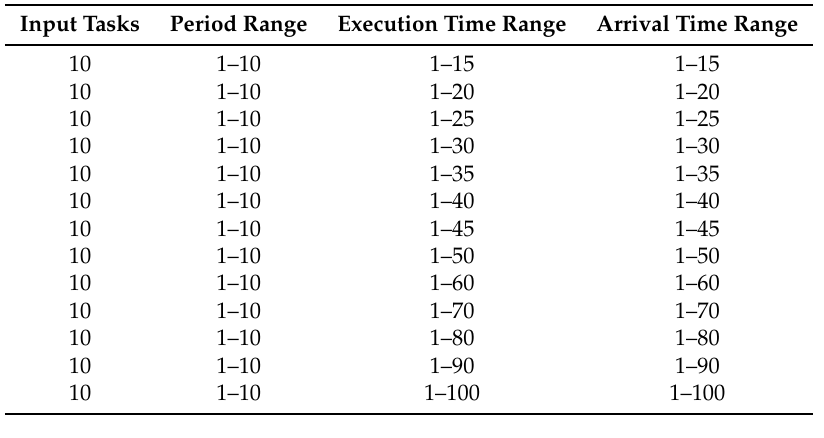
Table 6. Scenario: Changing execution time and arrival time range.